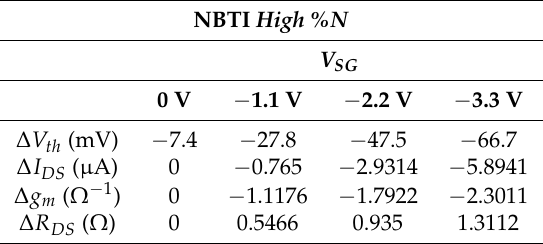
Table 4. Electric parameters’ degradation of the pMOS transistor with high %N, under one year of continuous